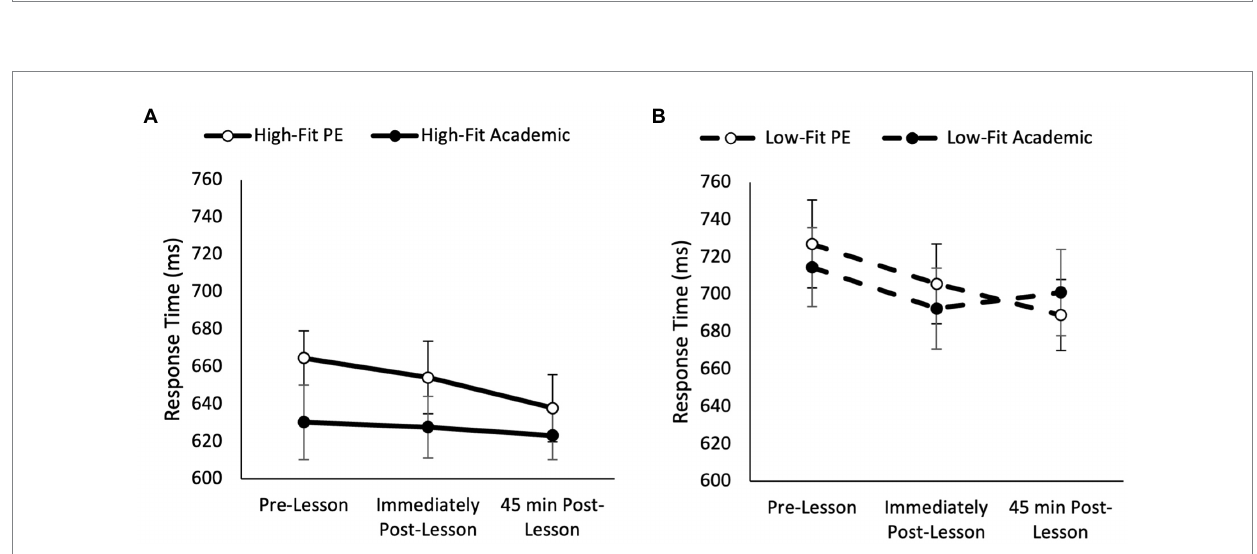
FIGURE 4 Response times across the morning on the five item level of the Sternberg paradigm on the PE and academic lesson trials for the high-fit (trial * time, p = 0.001; A ) and low-fit (trial * time, p = 0.863; B ) groups (trial * time * fitness, p = 0.023).